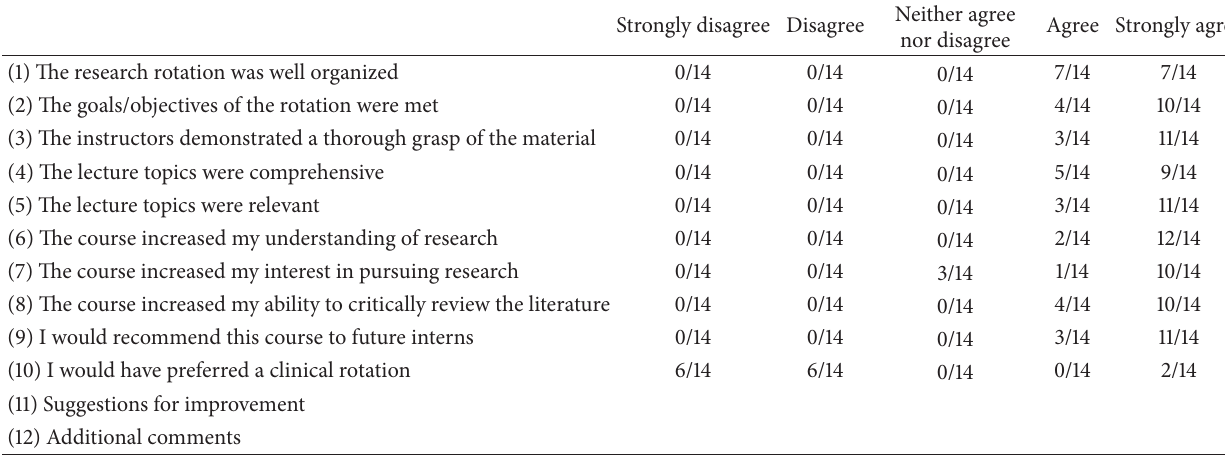
Table 2: Resident final course evaluation